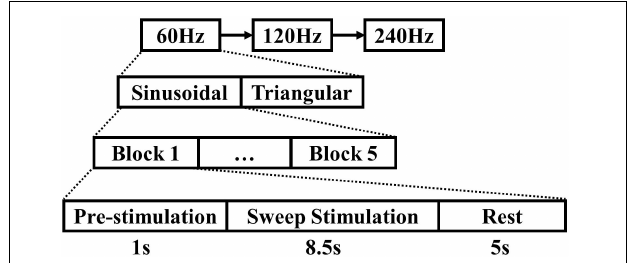
FIGURE 2 | Experiment process. The duration of stimulation was 8.5 s, the rest interval was 5 s, and the experiment block with the same parameters was repeated 5